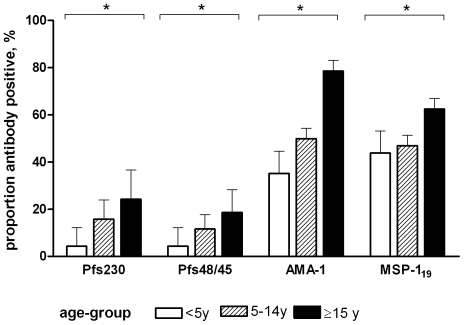
Antibody responses to Pfs230 and Pfs48/45 in relation to age.Bars indicate antibody prevalence in different age-groups, error bars the upper limit of the 95% confidence interval. Multiple observations are included per individual. Antibody responses to Pfs230 (p = 0.006), Pfs48/45 (p = 0.008), AMA-1 (p<0.001) and MSP-119 (p = 0.013) increased with increasing age, after adjusting for correlations between observations from the same individual. The number of observations for Pfs230, Pfs48/45, AMA-1 and MSP-119 were 69, 69, 31, 32 (<5 years), 168, 168, 134, 134 (5–14 years), 111, 111, 119, 81 (≥15 years). The asterisks indicates a statistically significant positive trend between antibody responses and age in all categories (p<0.05).